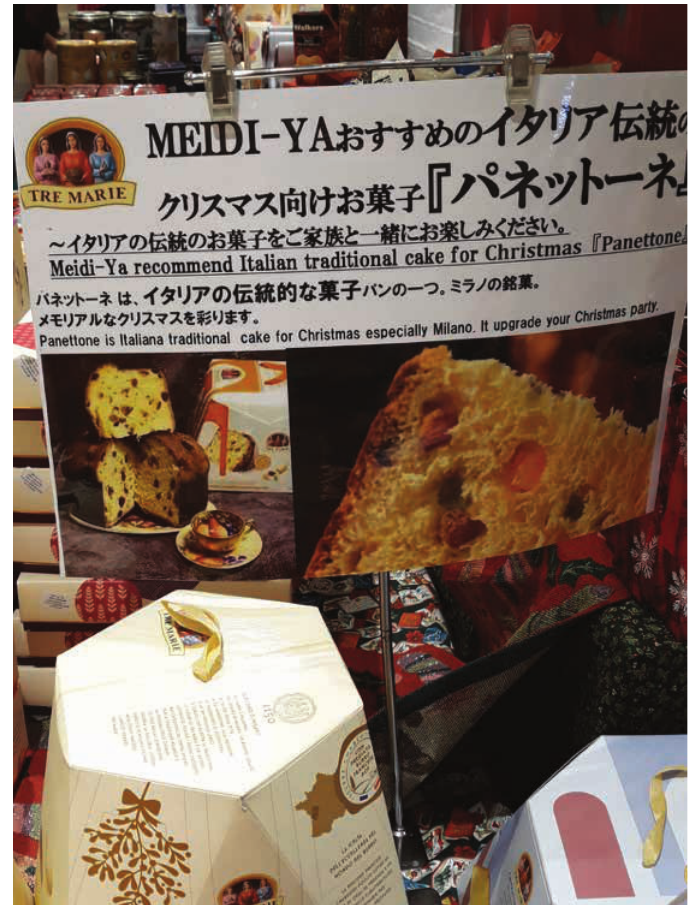
Figure 1: Panettone- Italian traditional cake for